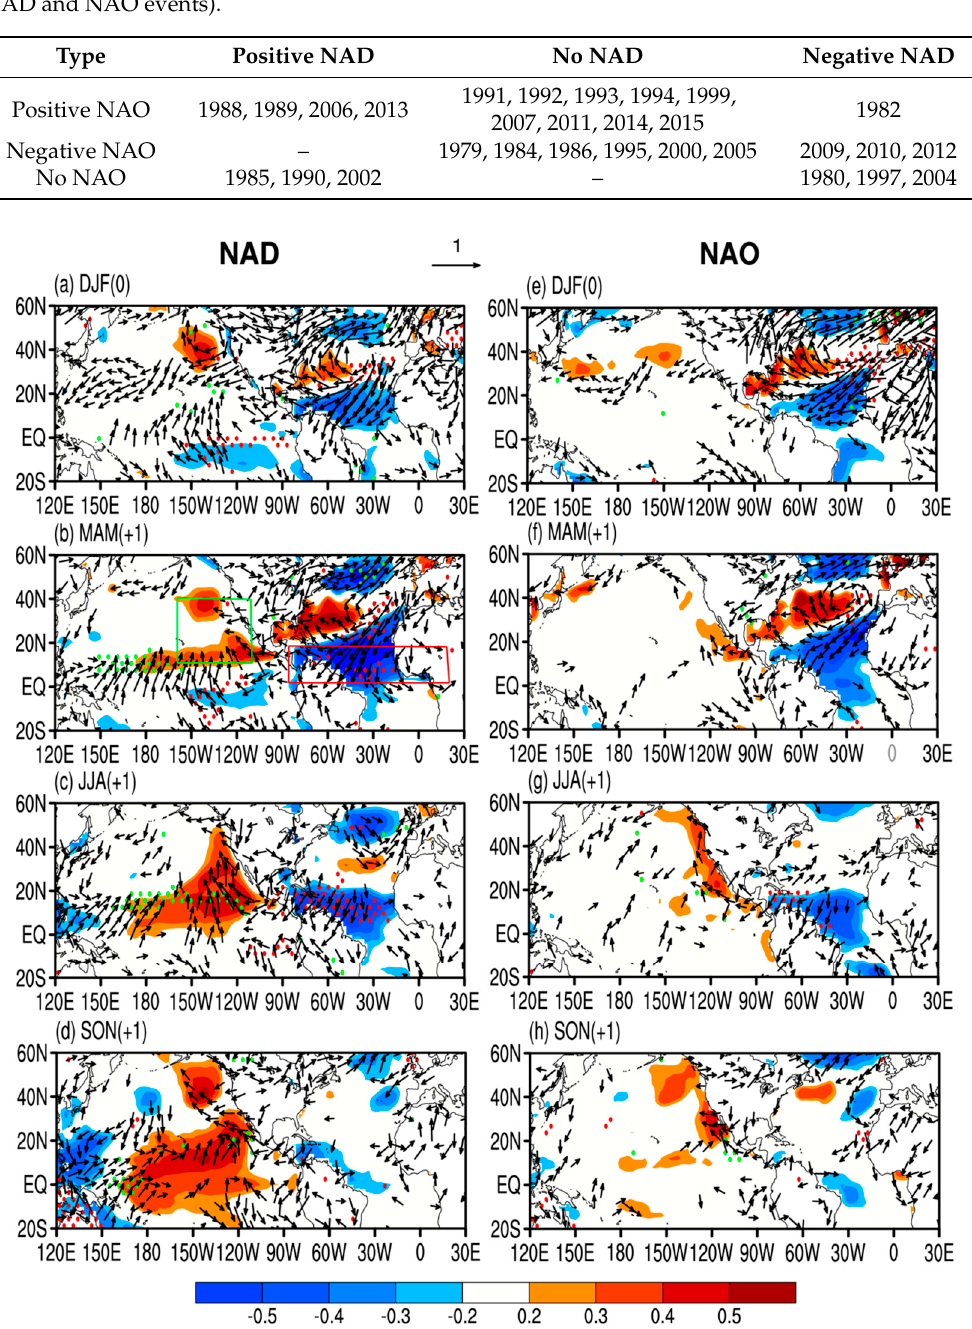
Figure 3. Correlation maps of the DJFM–averaged NADI with the three-monthly averages of SST (shading), surface wind (vectors), and precipitation (stippled) anomalies for ( a – d ) DJF(0), MAM(+1), JJA(+1), and SON(+1), and ( e – h ) the same relationships with the NAOI (0: year concurrent with the NADI (NAOI); +1: year after the NADI (NAOI)). Positive (green) and negative (red) precipitation anomalies with correlations significant at or above 90% confidence level are stippled. Only surface wind vectors significant at or above the 90% confidence level are shown. In (b), the green box indicates the locations of the NESP (160°–110° W, 10–40° N), and the red box indicates the locations of the NTA (85° W–20° E, 0–15° N).